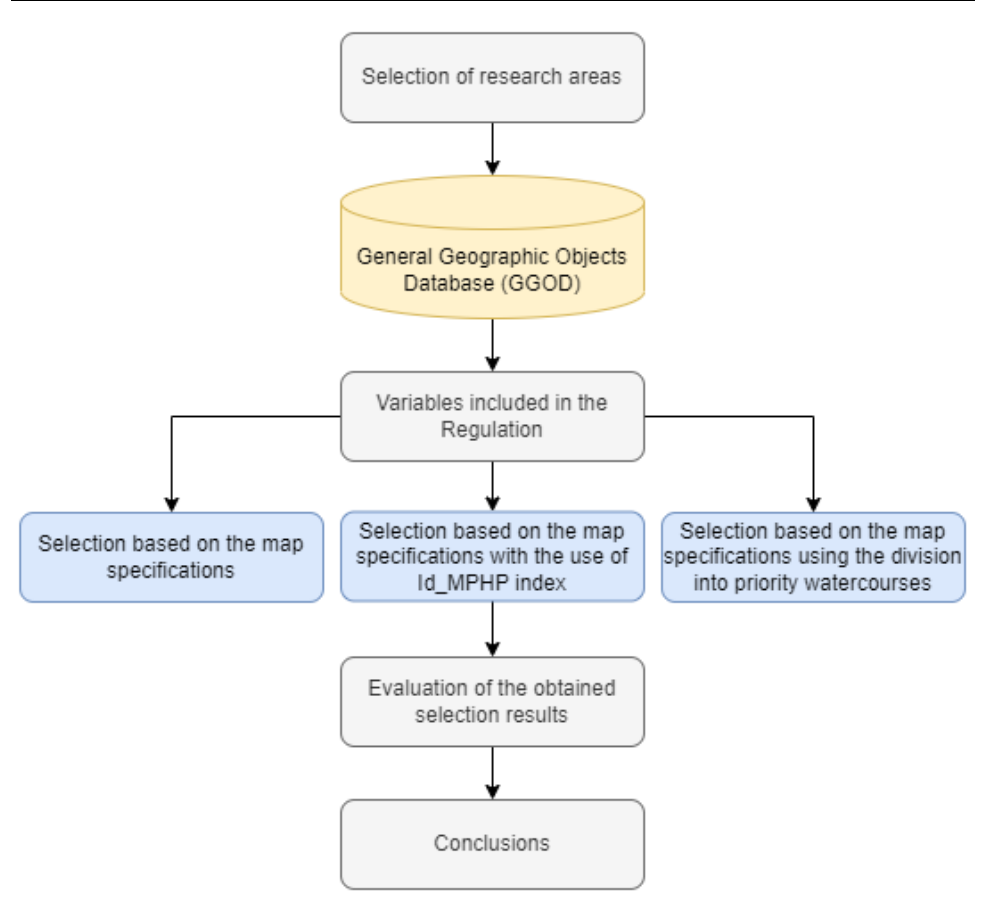
Fig. 1. Research schema, own elaboration. The yellow colour symbolizes the database used, the grey colour represents the methodology stages, and the blue colour represents particular variants of